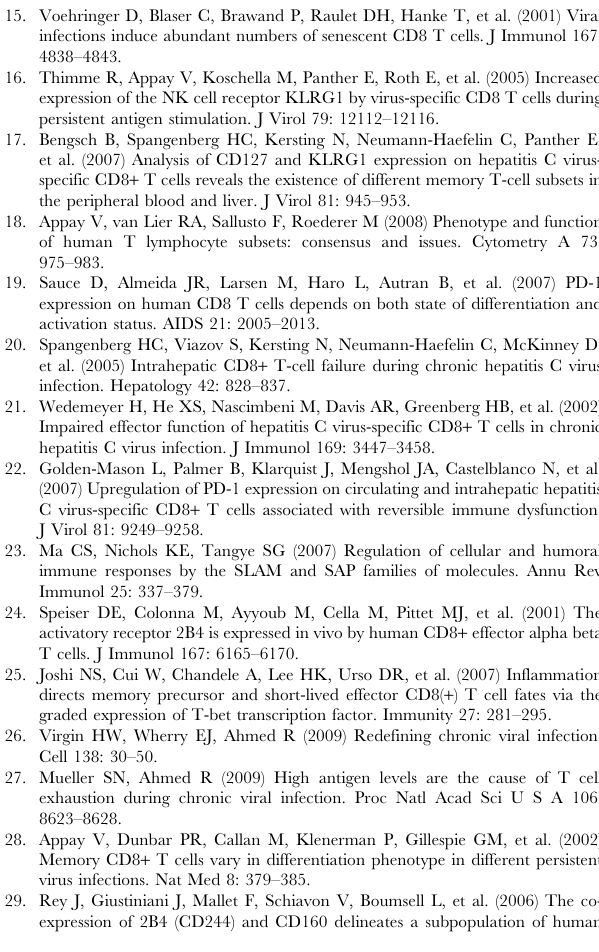
Figure S3 Analysis of Bcl-2 expression. In a total of 8 patients, Bcl-2 expression on HCV-specific CD8 + T cells was analyzed after cell permeabiliztion. Original data plots from patient 4 are shown and the MFI of tetramer-positive cells is displayed. Bcl-2 expression correlated with the level of CD127 expression. The coexpression of inhibitory receptors of the displayed HCV-specific CD8 + T cells is shown in Fig. 3C.